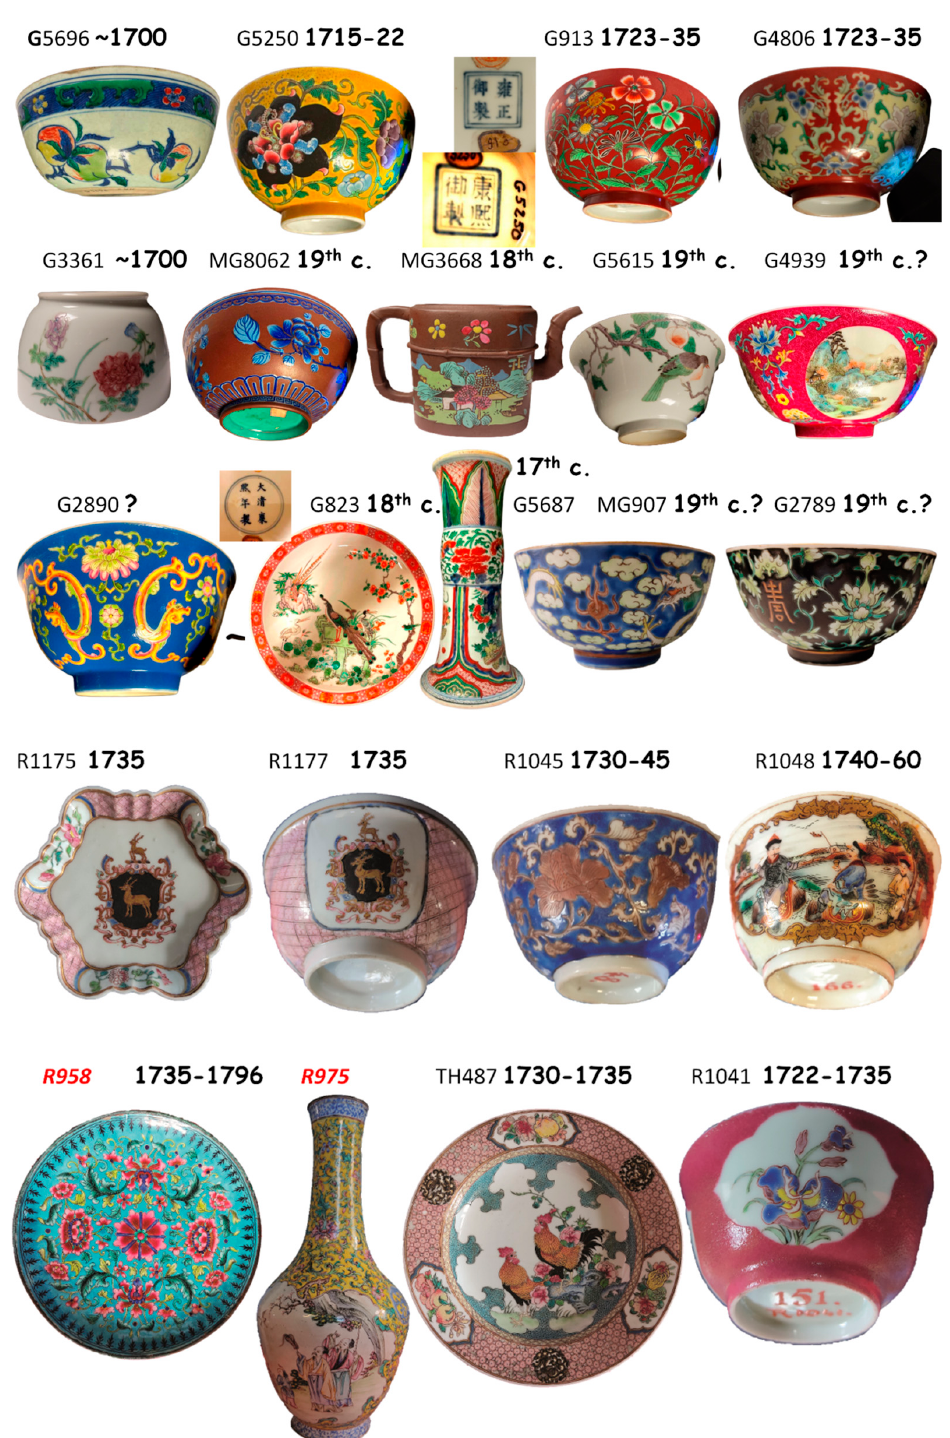
Figure 1. View of analyzed artifacts. Existing marks are presented. The allocated production period is specified (see Table 1 for details).